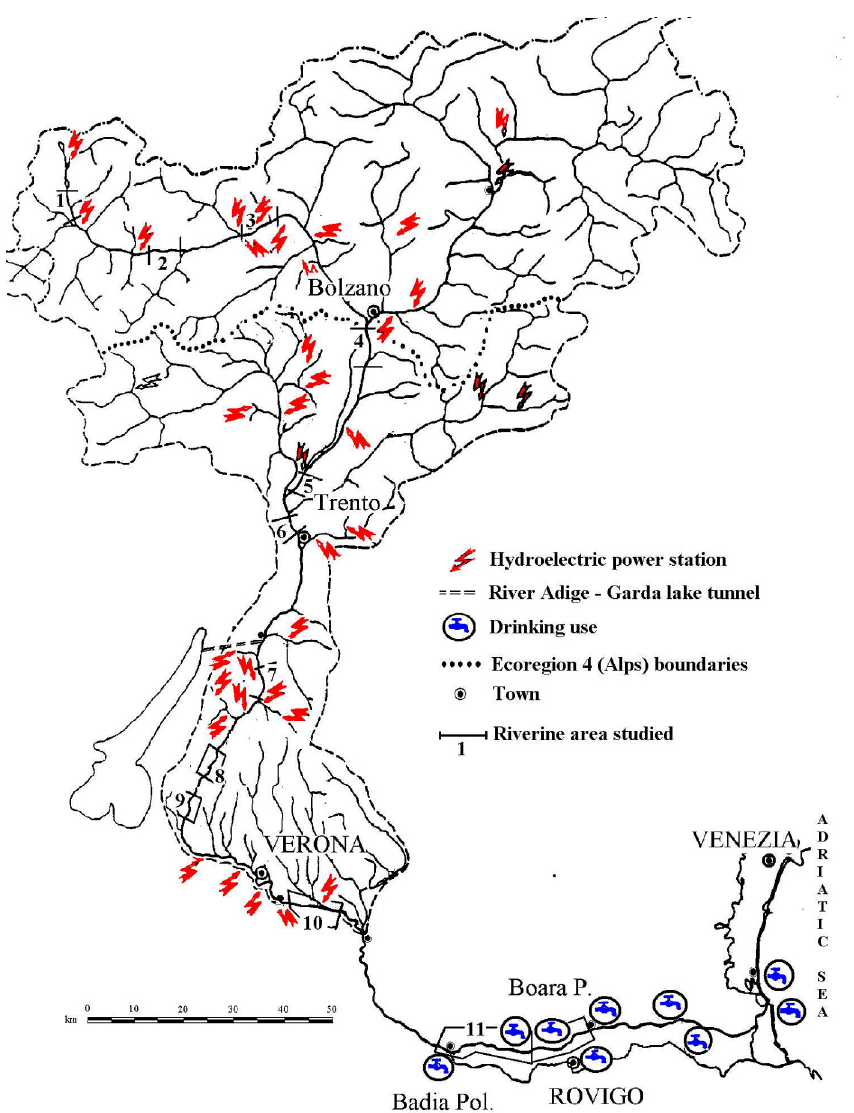
FIGURE 3. The Adige River Basin and the 11 areas of the fluvial corridor inventoried. Areas 8 through 11 are displayed in the square (modified from [13]).